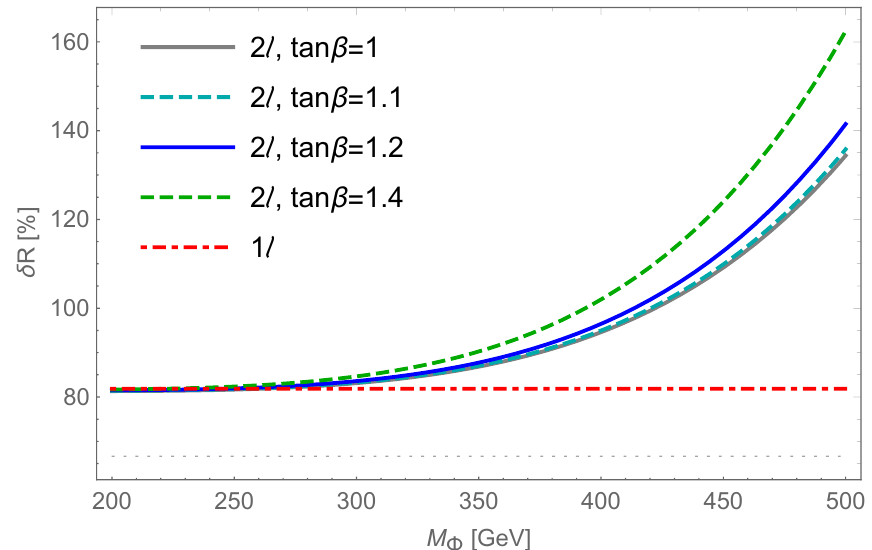
Figure 8 . BSM deviation δR — defined in eq. (3.12) — of the Higgs trilinear coupling ˆ λ hhh computed at one loop (dot-dashed line) and at two loops (solid and dashed curves) in the CSI- 2HDM with respect to its SM prediction as a function of the degenerate mass of the BSM scalars M Φ = M H = M A = M . The different grey, teal, blue, and green two-loop curves correspond H ± respectively to tan β equal to 1, 1.1, 1.2, and 1.4. As in the previous section, the black dotted line is obtained by comparing the one-loop CSI result for λ hhh to the SM tree-level